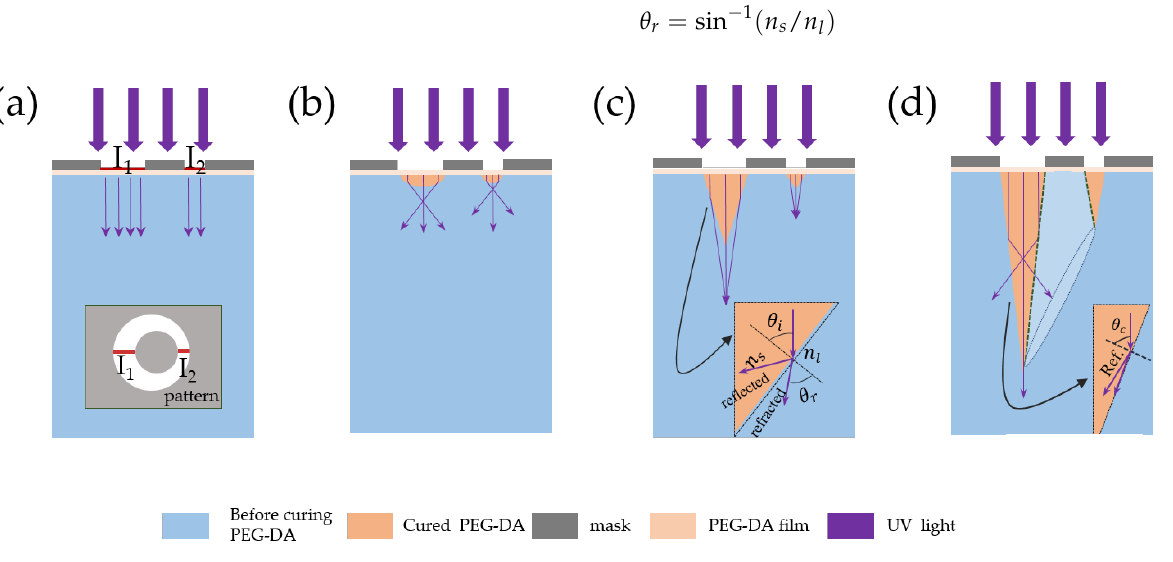
Figure 2. Principle of lithography on the foundation of variable refraction index PEG-DA. UV refracted at the interfacial region of the uncured and photocured PEG-DA. ( a – d ) The formation pro- cess of hollow microneedles.